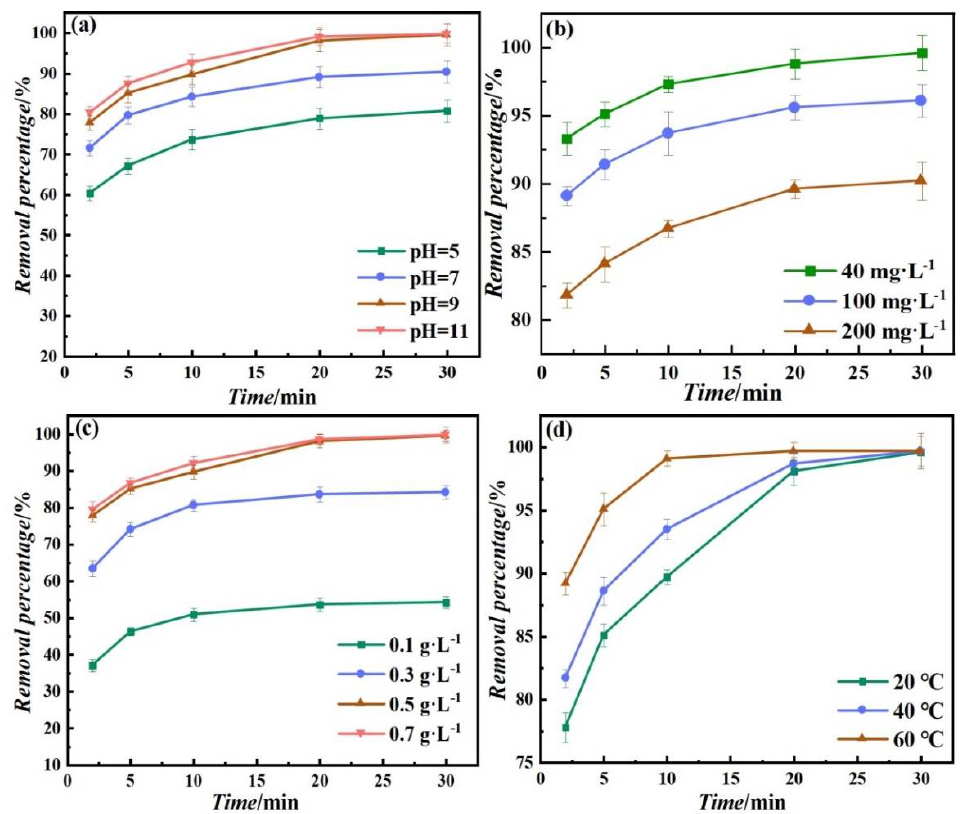
Figure 7. ( a ) Effect of pH on degradation of MB, in the context of 0.5 g·L −1 nZVI@H with a temper- ature of 20 °C and an initial MB concentration of 40 mg·L −1 ; ( b ) effect of initial concentration on degradation of MB, at the original pH (9) and temperature (20 °C) using 0.5g·L −1 nZVI@H; ( c ) effect of dosage on degradation of MB, with a pH of 9, an initial MB concentration of 40 mg·L −1 and a temperature of 20 °C; ( d ) effect of temperature on degradation of MB, in the context of 0.5 g·L −1 nZVI@H with a pH of 9 and an initial MB concentration of 40 mg·L −1